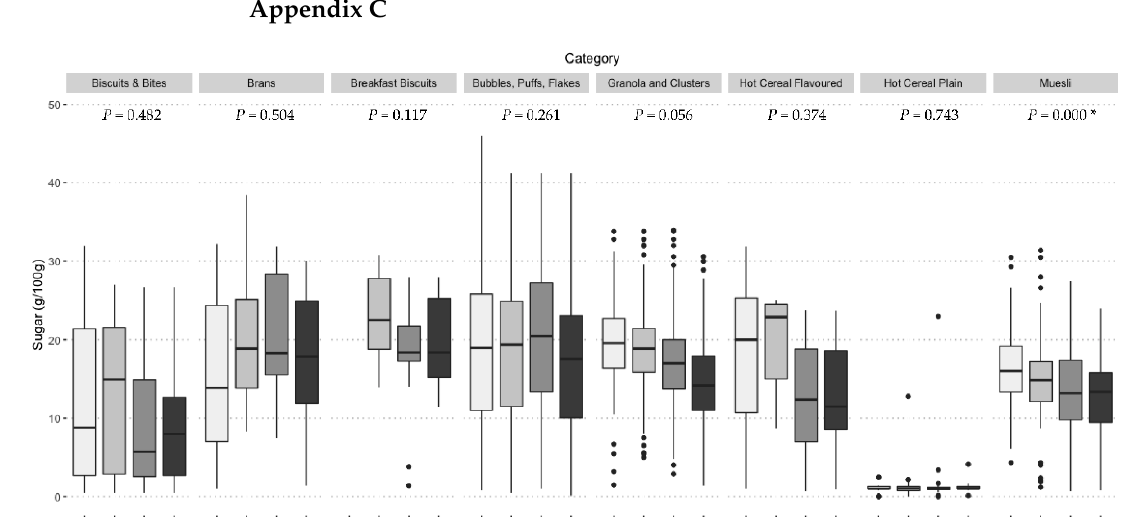
Figure A2. Carbohydrate content of breakfast cereals (g/100 g) between 2013, 2015, 2018, and 2020; p value comparing 2013 vs. 2020 (2015 vs. 2020 for breakfast biscuits). * Statistically significant p < 0.05.